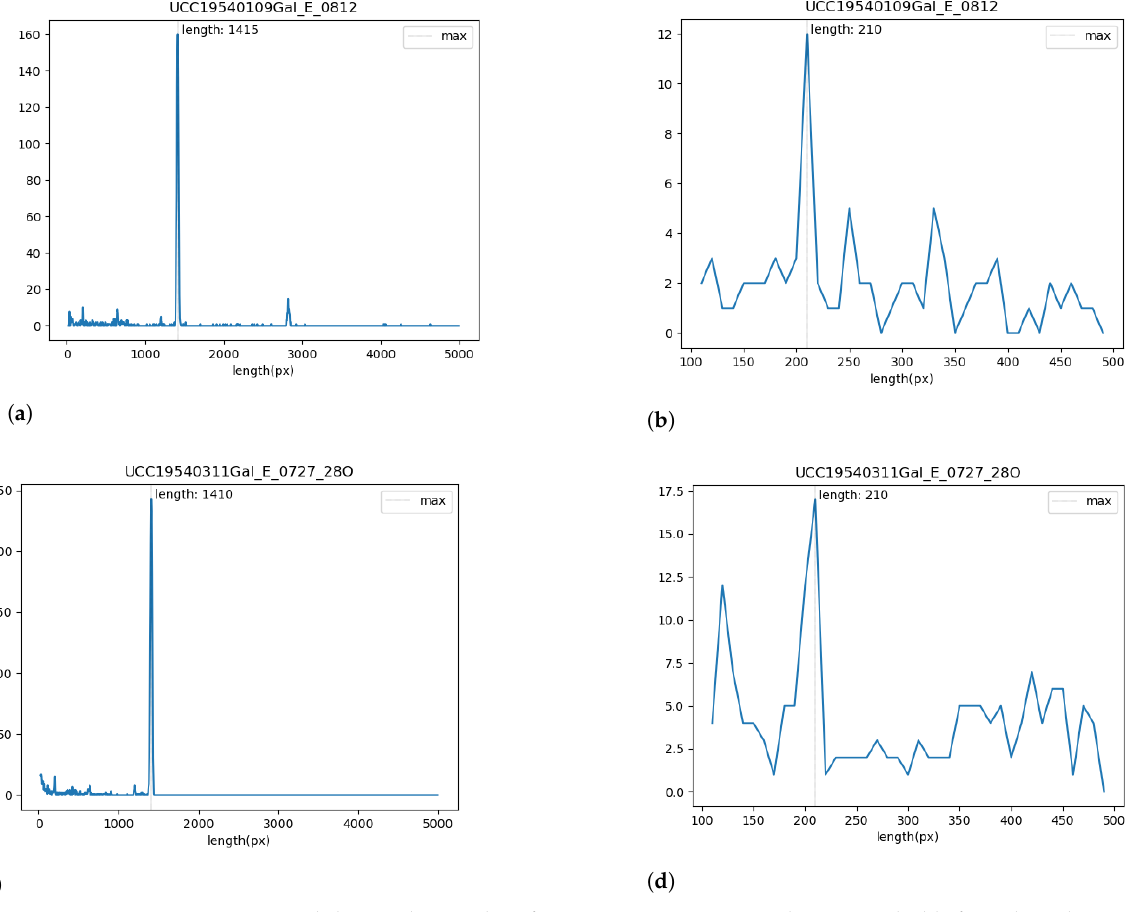
Figure 21. Validating the results of segments tracing in Python, Matplotlib for selected seismo- gram. ( a , c ): Frequency of segment length: size of various segments in a trace. ( b , d ): Analy- sis of statistics on segment length per hours of recording. ( a , b ): UCC19540109Gal_E_0812.mat ( c , d ):